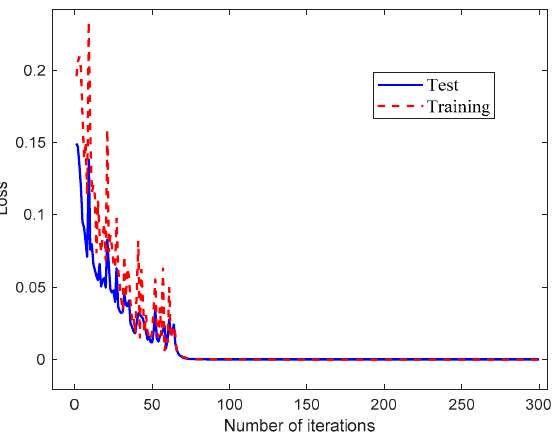
Figure 6. Loss function curve of the fault diagnosis model based on the TSCNN.